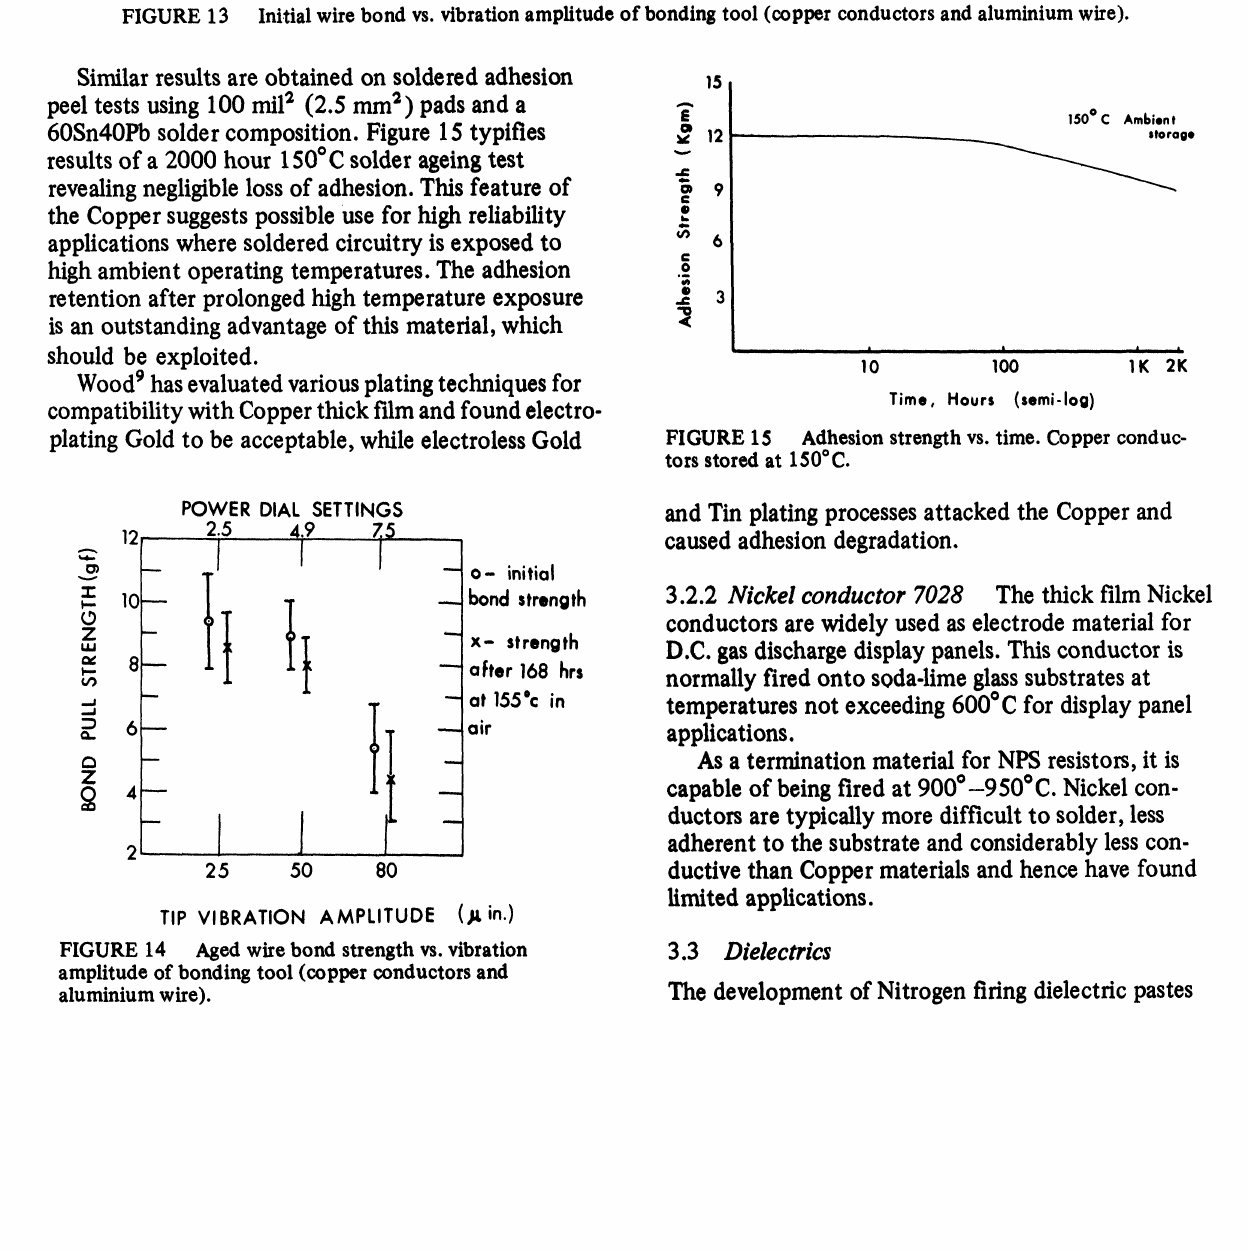
Aged wire bond strength vs. vibration amplitude of bonding tool (copper conductors and aluminium